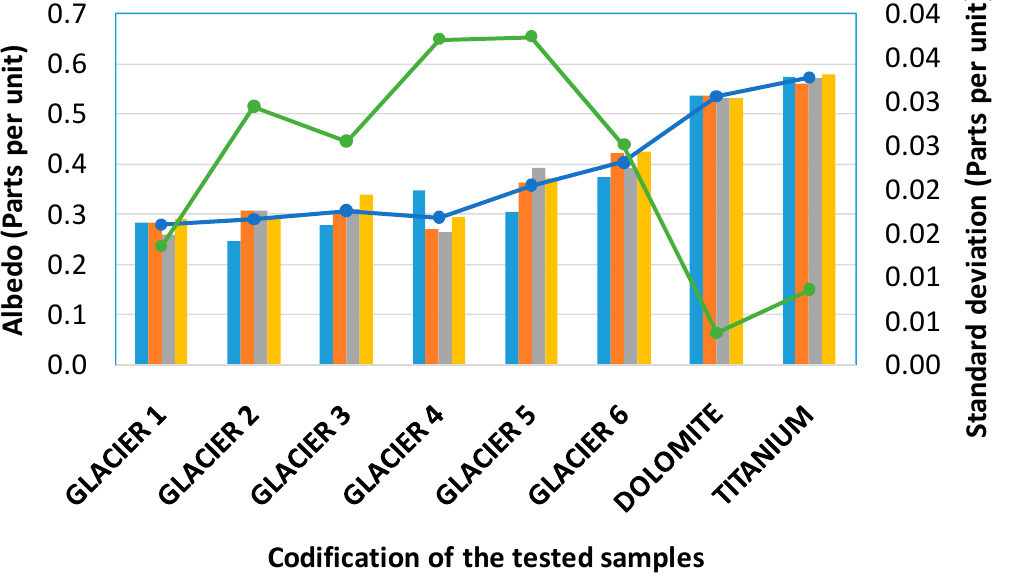
Figure 2. Individual albedo results (bars), average albedo, R m (green line) and standard deviation (blue line).